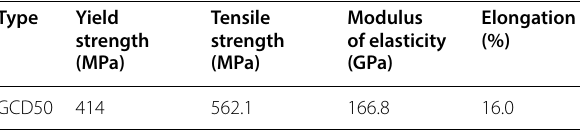
Table 3 Material properties of splice sleeves.